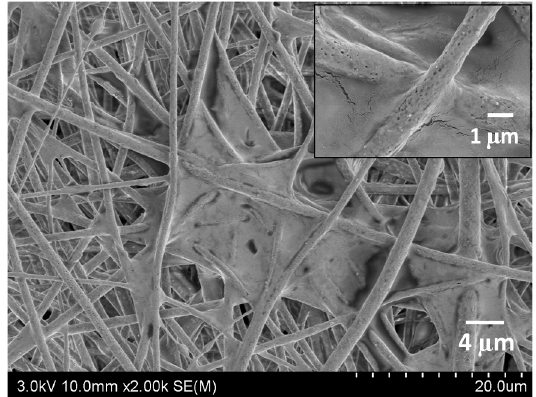
Figure 9. FE-SEM image of PLA/chitosan fibrous membranes after the air purification experiment.